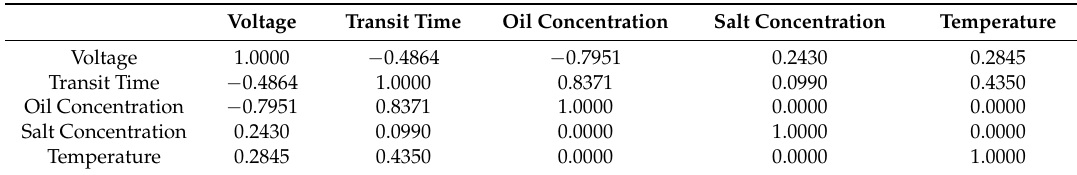
Table 1. Simple correlation coefficients of input and output